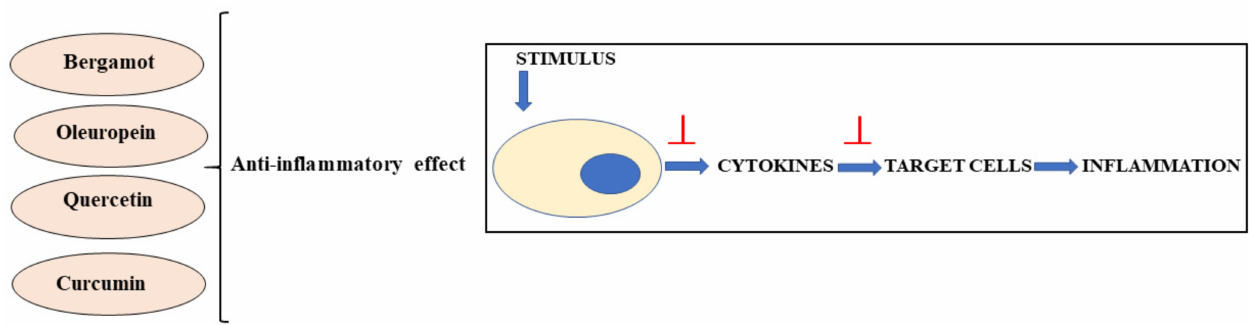
Figure 5. Anti-inflammatory effects exerted by bergamot, oleuropein, quercetin and